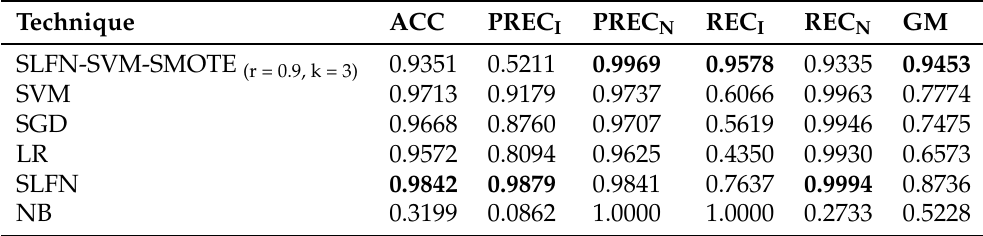
Table 4. Comparison of SLFN-SVM-SMOTE (r = 0.9, k = 3) with basic